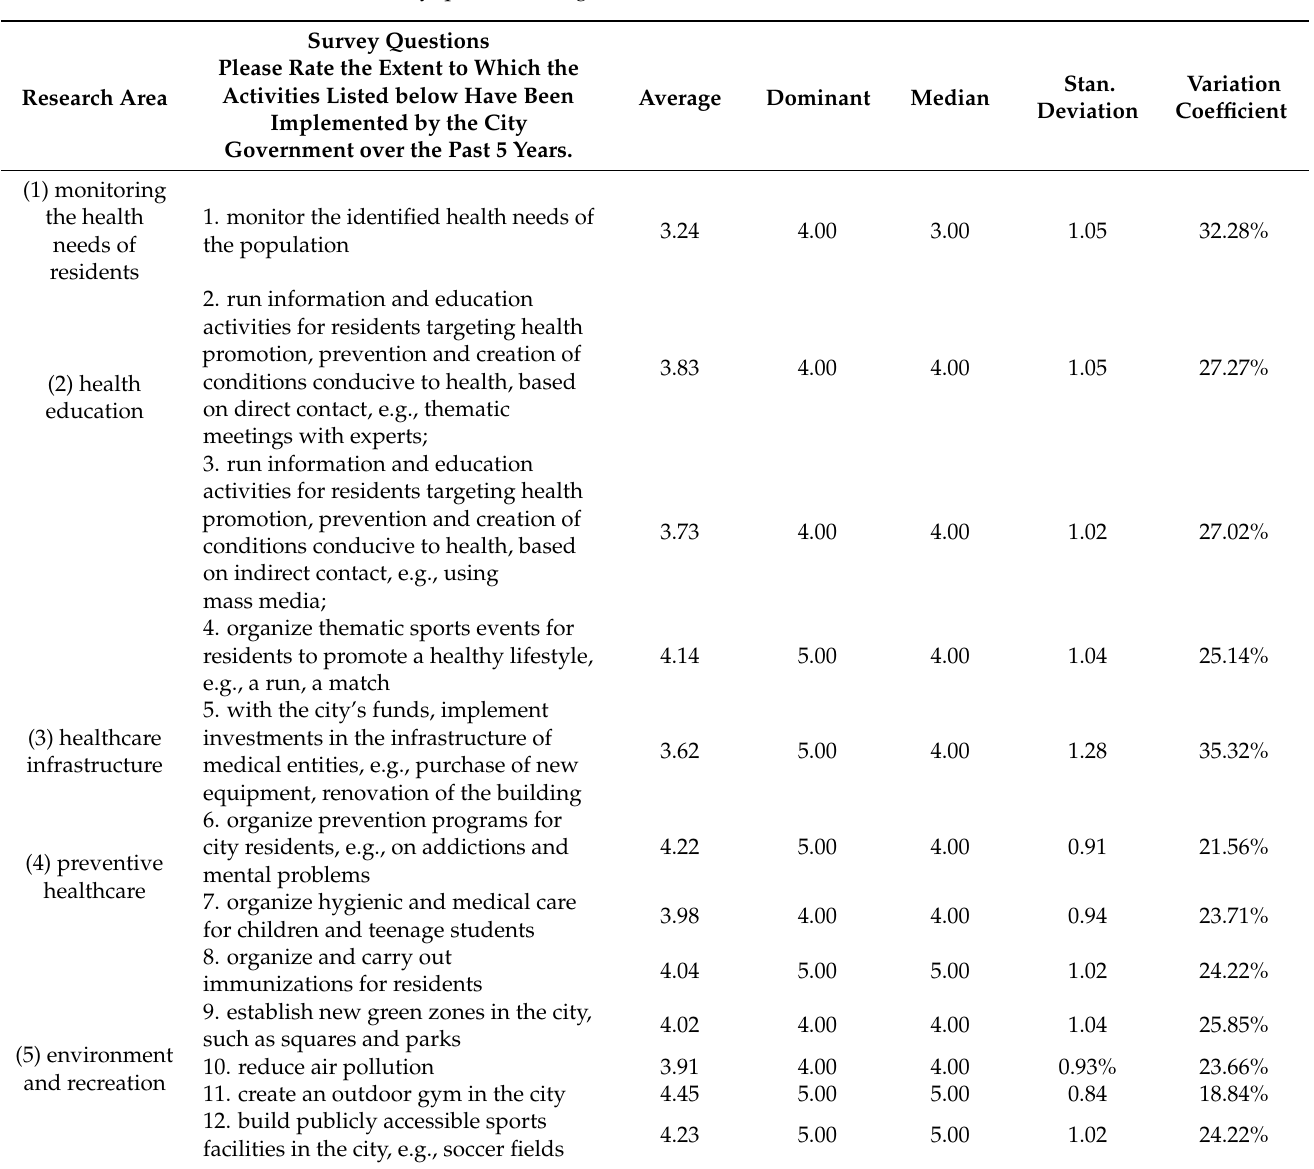
Table 2. Results of assessing the city government’s commitment to residents’ healthcare, along with the survey questions assigned to